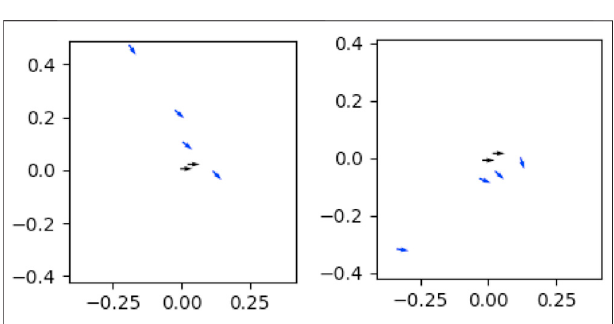
FIGURE 8 | Each plot represents one set of corrections for a task. The positionofeach arrow represents thechangein < x , y > position, andpoints in the direction of the change in orientation introduced by that correction. Orientation constraints can be seen in (A) , where the majority of corrections on this tool have low variance in their orientation, but higher varianceintheir x - y position.Center-of-rotationconstraintscanbeseenin (B) , where the majority of corrections arc around a singular center of rotation, and orientation is dependent on the x - y position. Unconstrained keyframes (colored grey) are located near